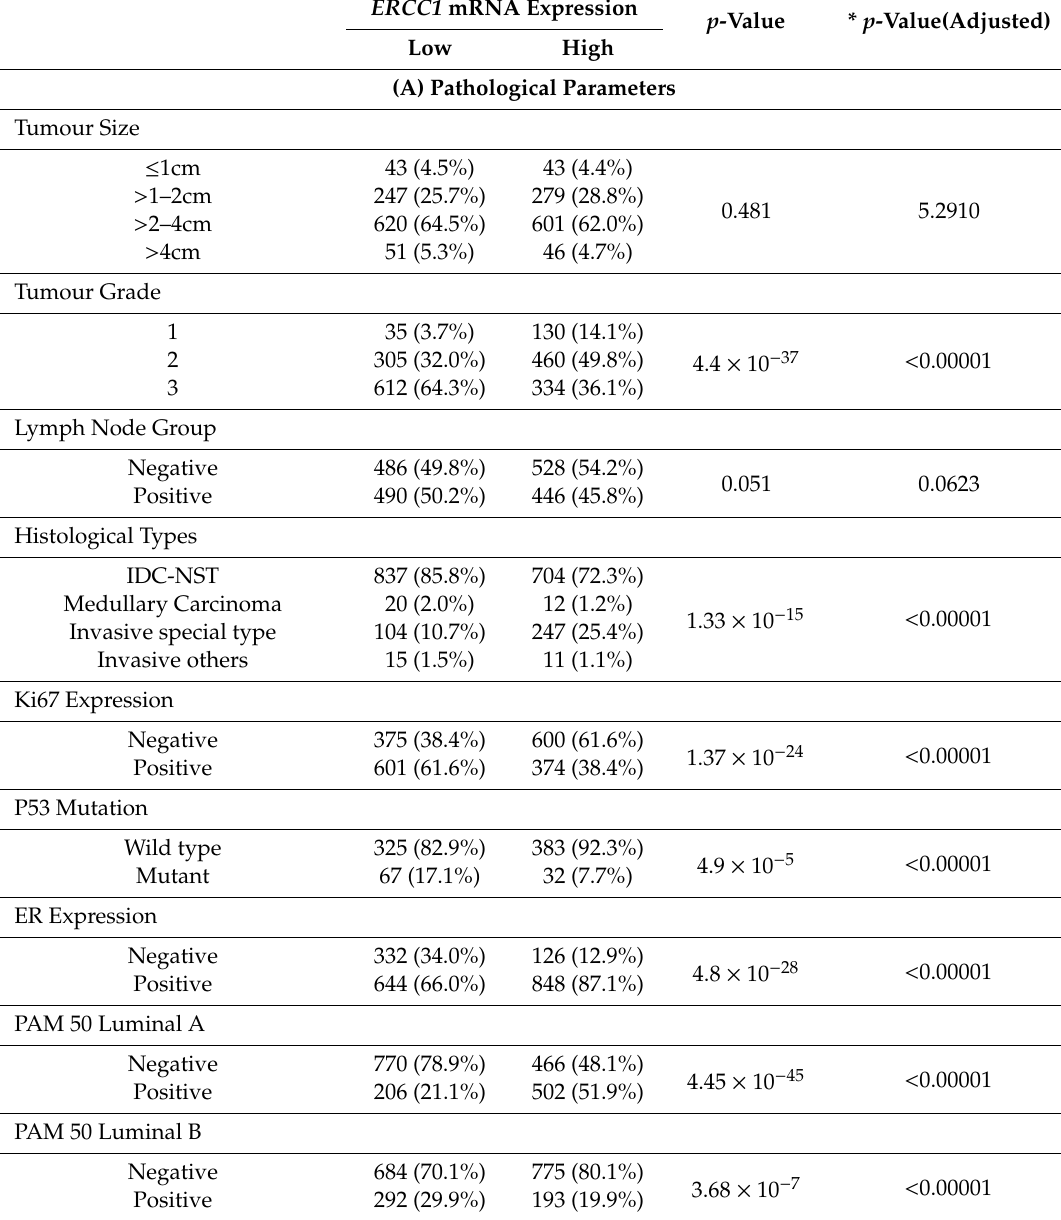
Table 1. Clinicopathological significance of ERCC1 mRNA expression in breast